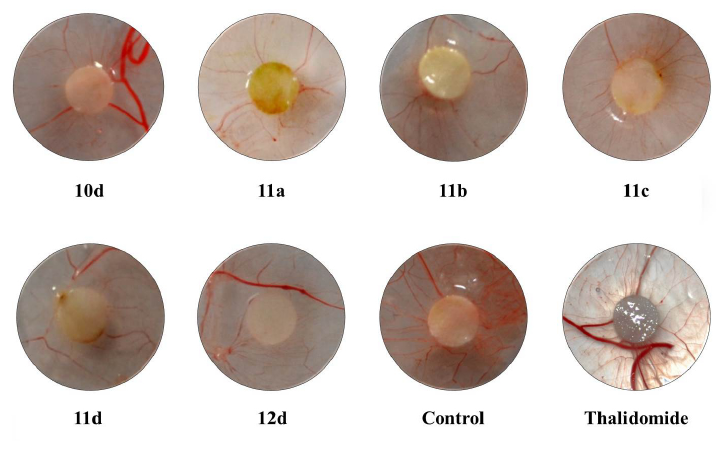
Figure 3. The results of CAM assay. NaCl solution (0.9%) and thalidomide were used as a negative control and a positive control, respectively. Representative pictures of independent experiments performed in duplicate for the quinazoline derivatives 10d , 11a – d and 12d doses and controls. All filter discs had the same size, and any visual size differences are due to the various distances from which pictures were